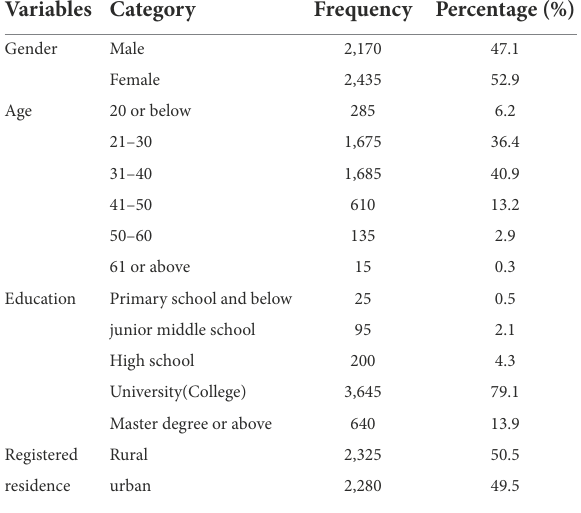
TABLE 2 Demographic profile of respondents (N =